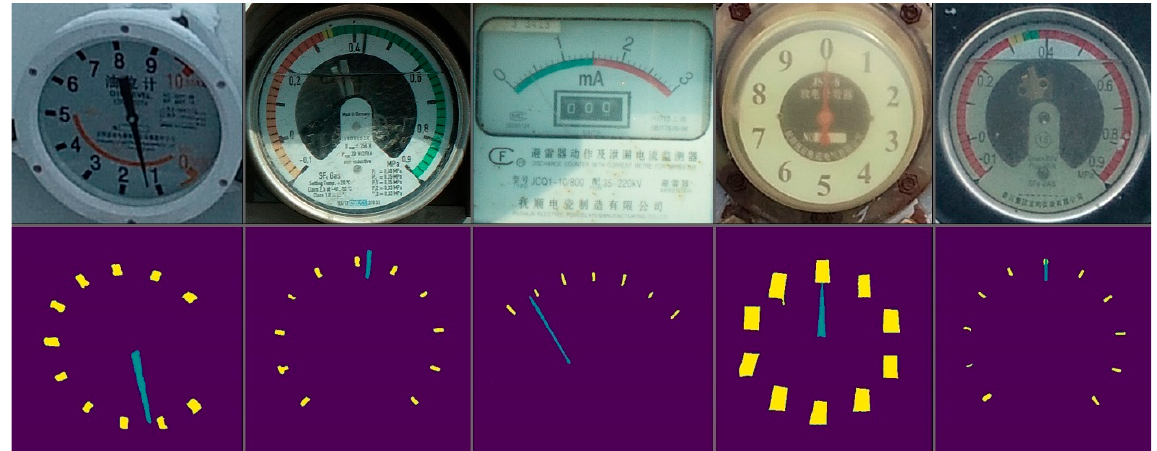
Figure 7. Image segmentation results of Deeplabv3+.